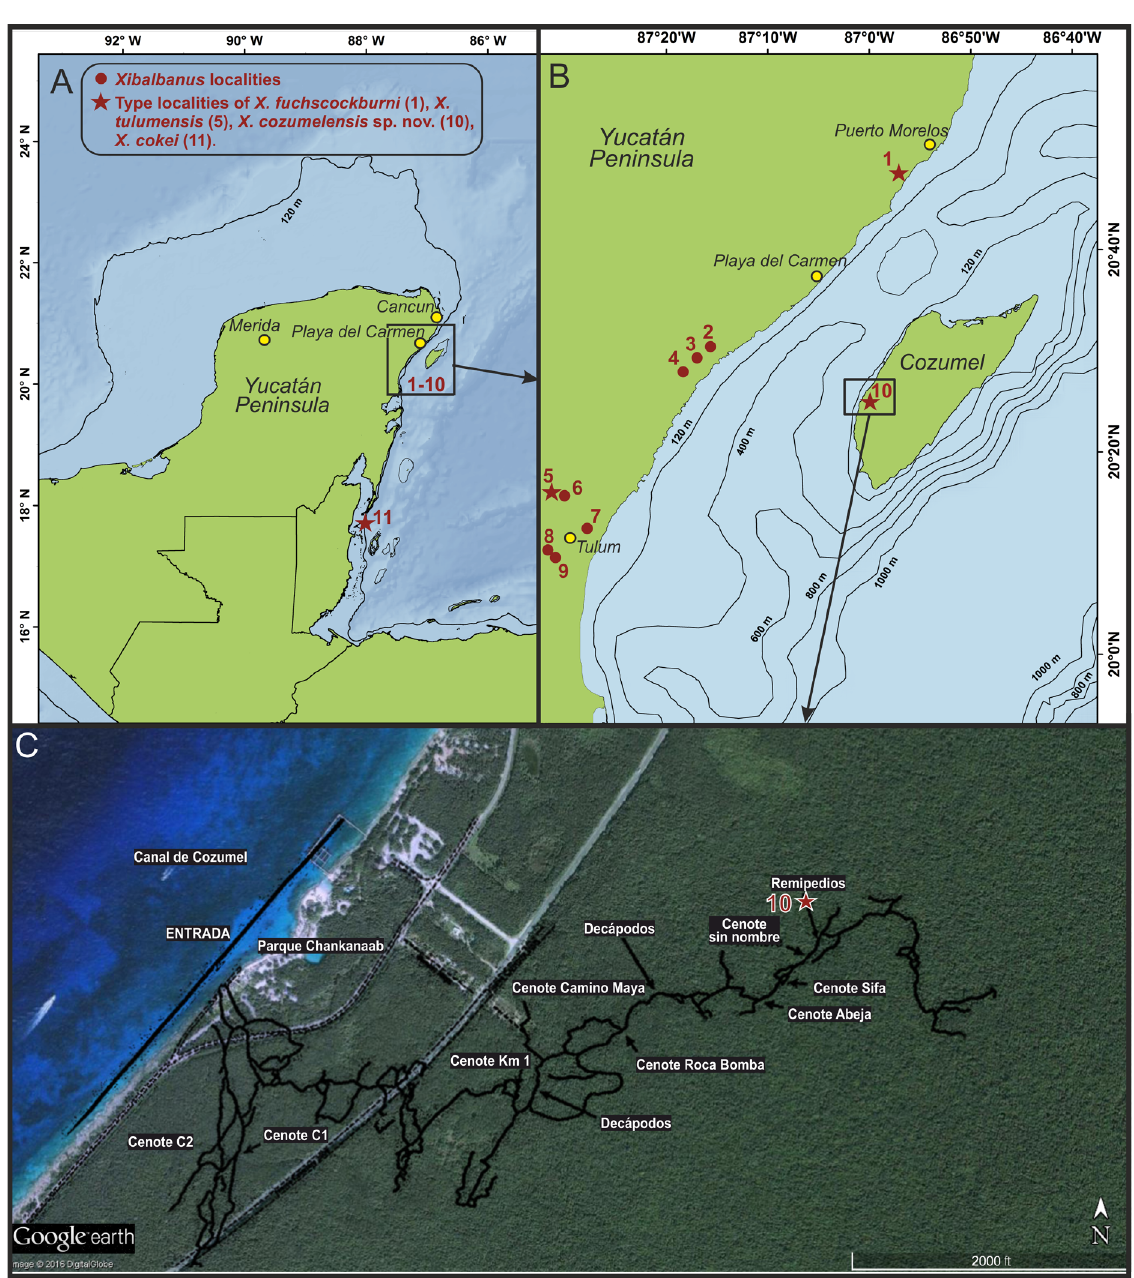
Fig. 2. Maps of the Yucatán Peninsula showing the known distribution of four species of Xibalbanus (Remipedia) and water depths around Cozumel. A . Yucatán Peninsula showing Xibalbanus localities (1–10) in the northeastern region of the Yucatán Peninsula and one locality in Belize further south (11). B . Close-up of the northeastern region of the Yucatán Peninsula with the positions of 10 Xibalbanus localities indicated. C . Close-up of eastern Cozumel with the branches of the anchialine cave “Cueva Quebrada” indicated as an overlay, derived from Yañez-Mendoza et al . (2007). The collecting site of Xibalbanus cozumelensis sp. nov. is indicated as “10”. Numbers refer to the following